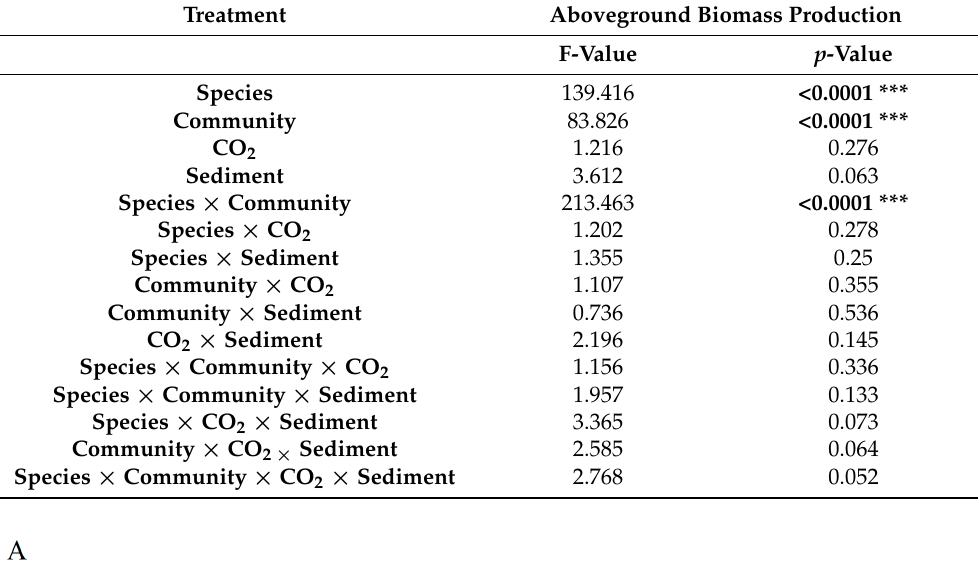
Table 1. ANOVA summary table reporting F- and p -values for main effects and interactions for aboveground primary productivity. Significant values in bold. Significant levels: *** p < 0.001.